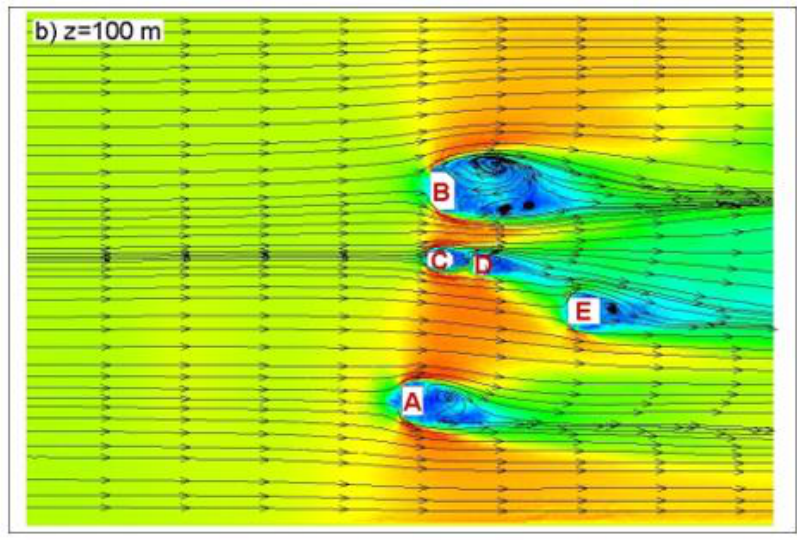
Figure 6. 2D streamlines and velocity magnitude contours at ( a ) z = 15 m; ( b ) z = 100 m planes (see the location of planes in Figure 2).